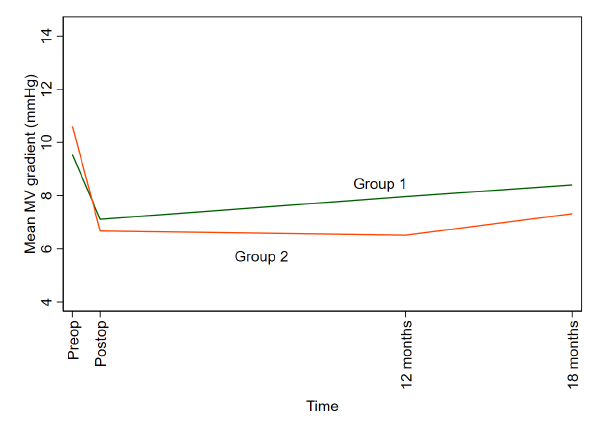
Fig. 2A-C – Kaplan-Meier distribution of survival, reoperation, and cardiac